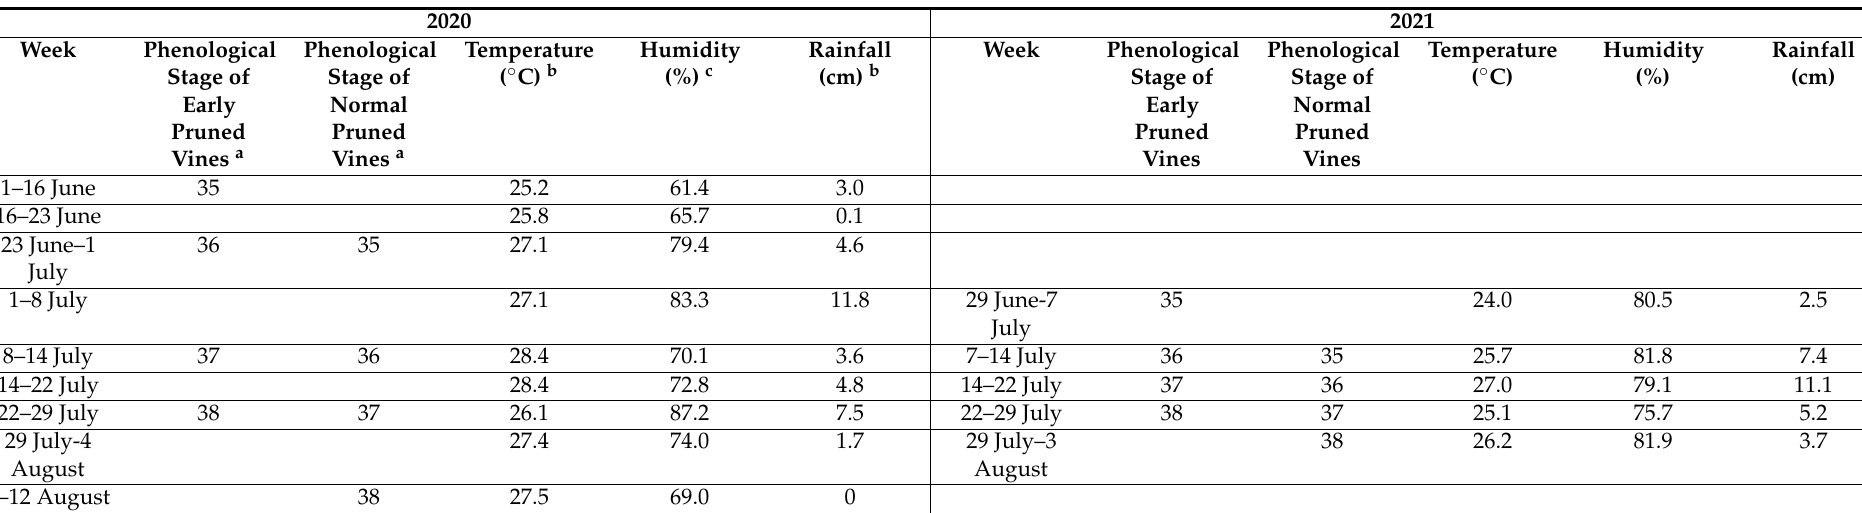
Table 1. Weekly phenological stage, rainfall, and average temperature and humidity near McNeill, MS starting from ‘MidSouth’ veraison to harvest for vines